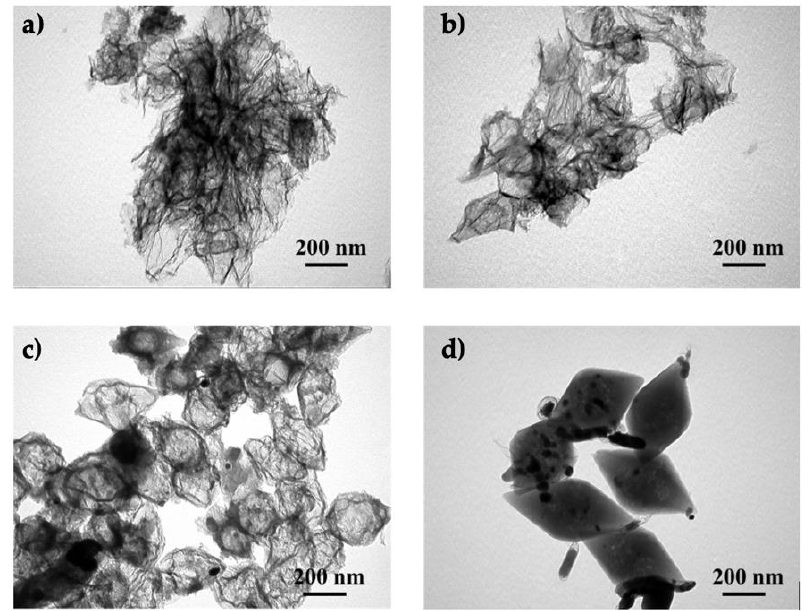
Figure 6. The effects of different PA loadings for the modification of hollow carbon nanostructures: Morphologies of materials treated with ( a ) 1 mL, ( b ) 0.5 mL, ( c ) 0.2 mL, and ( d ) 0.1 mL of PA. Reproduced with permission from [66]. Copyright 2020 Elsevier Inc. All rights reserved.